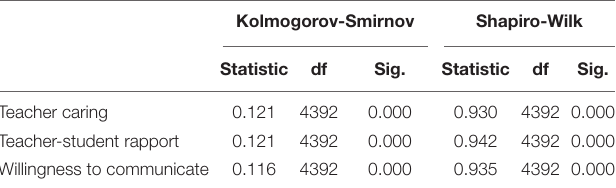
TABLE 1 | Tests of normality for the variables.